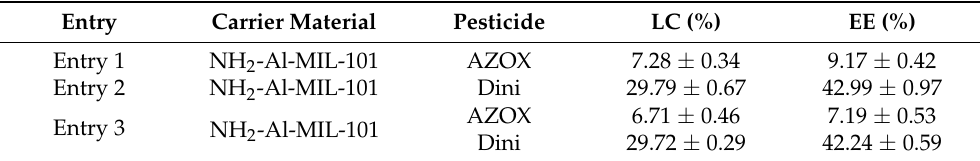
Table 2. Results of loading content (LC) and encapsulation efficiency (EE) of AZOX and Dini into NH 2